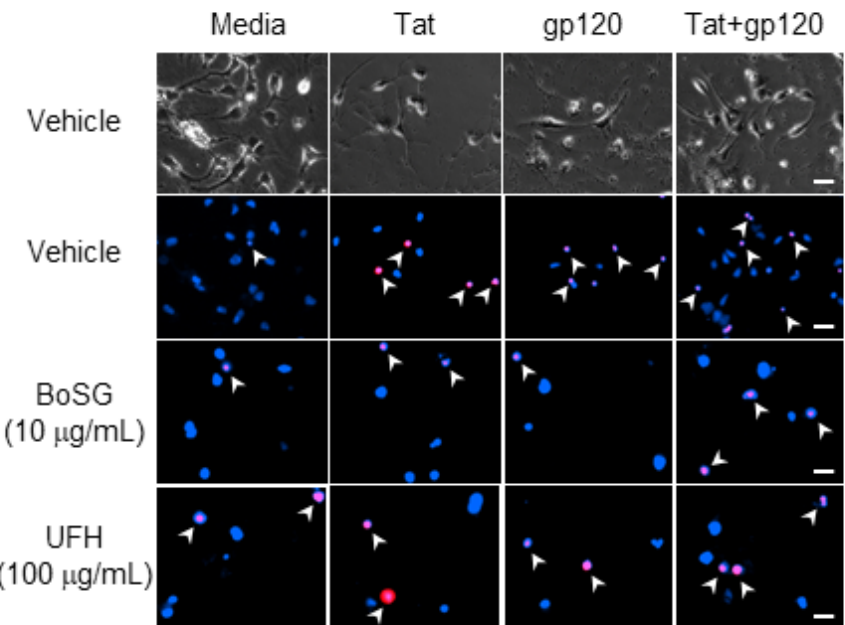
Figure 2. Representative photomicrographs (40× ) of C57BL/6N, striatal, medium spiny neurons co-exposed to Botryocladia occidentalis sulfated galactan (BoSG) or unfractionated heparin (UFH) and the HIV proteins, Tat (50 ng/mL) and/or gp120 (500 pM). Total cell number was assessed via Hoechst 33342 (blue) and cell death was confirmed via propidium iodide (red). Arrows indicate examples of propidium-iodide-positive cells. Scale bar = 20 μ M.